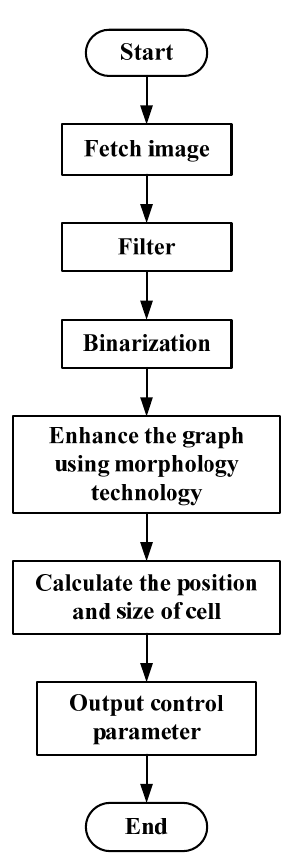
Figure 2. Flow chart of the image software